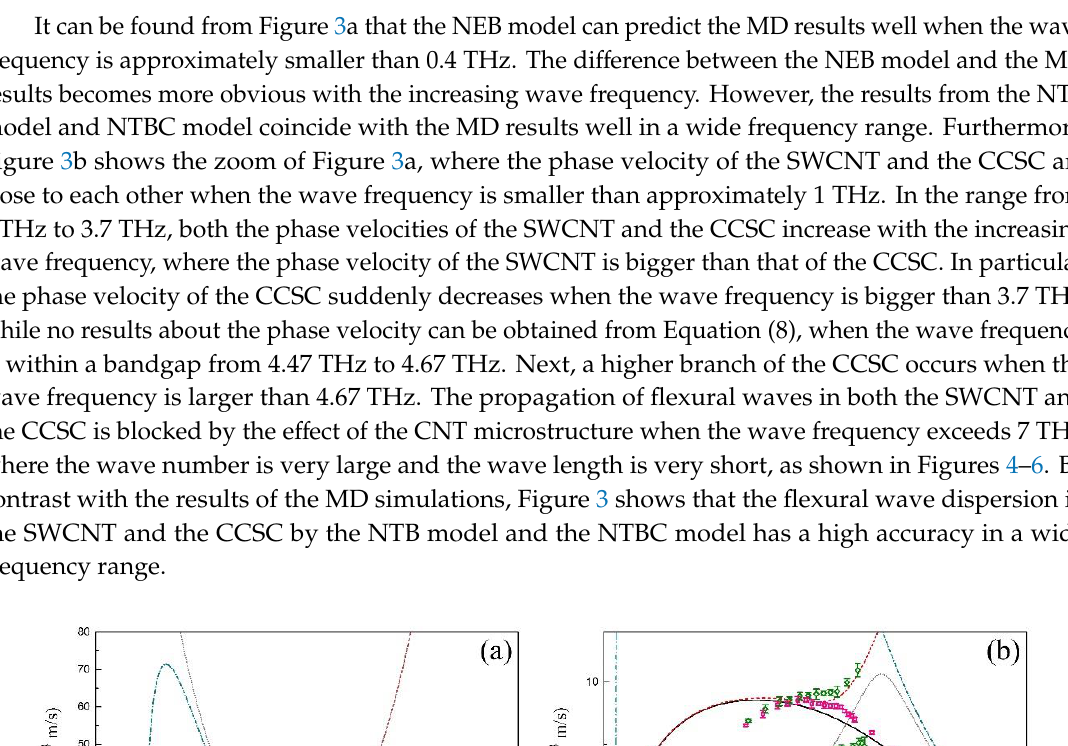
Figure 4. ( a ) The dependence of the phase velocity on the wave length of the SWCNT and the CCSC; ( b ) the zoom of ( a ).